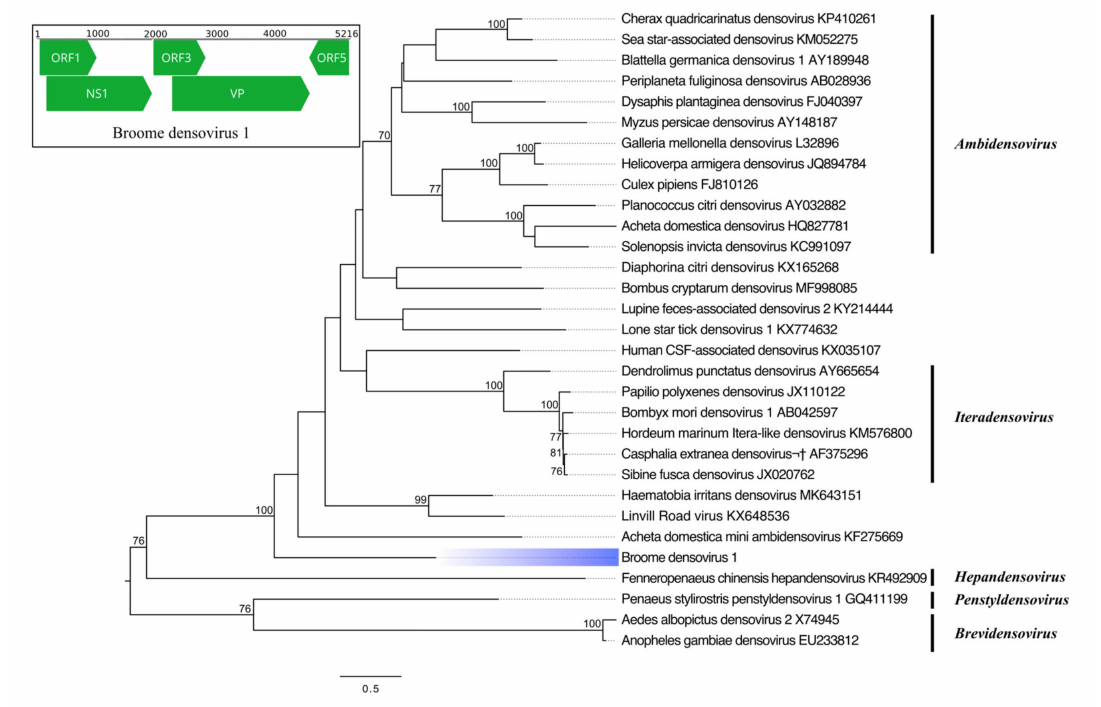
Figure 4. Phylogenetic analysis of Broome densovirus 1. The maximum likelihood tree was constructed using NS1 protein sequences. The scale bar represents units of substitutions per site, and bootstrap support values are displayed when greater than 70%. Viruses identified in this study are highlighted in blue. Inset: Genome organization of Broome densovirus 1. Open reading frames (ORF) are indicated by green arrows, while nucleotide positions are shown above the genome. NS1, non-structural protein 1; VP, viral capsid protein.